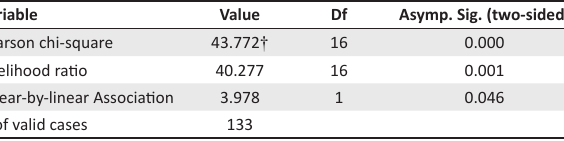
TABLE 4b: Chi-square